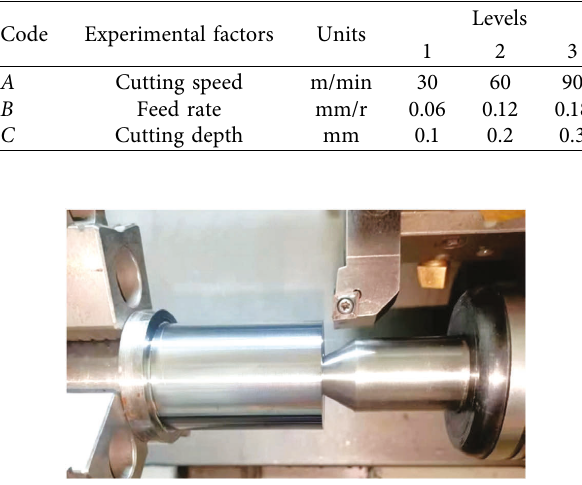
Figure 1: The experimental